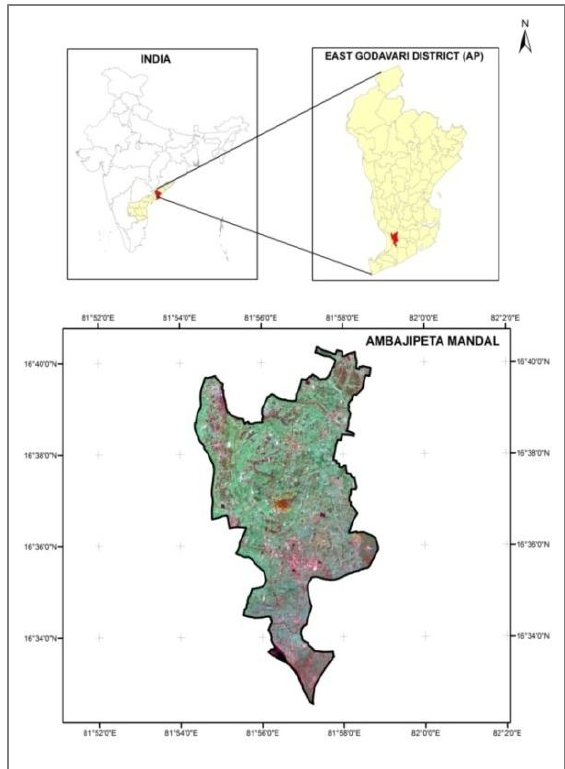
Figure 1: Location of study area